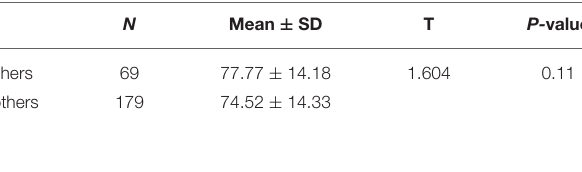
TABLE 2 | Level and comparison of resilience between fathers and mothers.